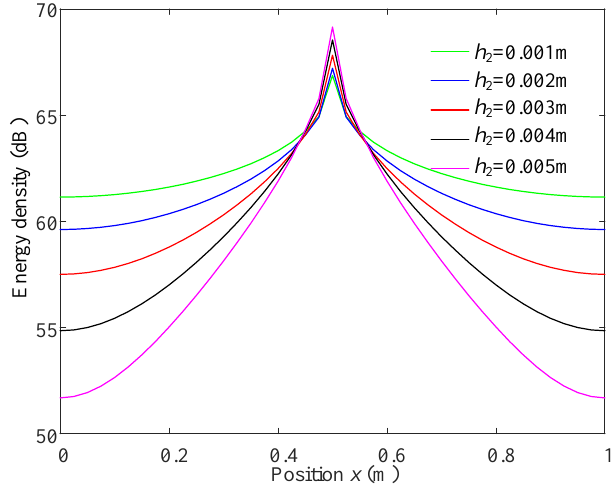
Figure 7. Energy density distribution for a plate with FFLD treatment of various loss factor of damp- ing layer ( f = 3 kHz, h 2 = 0.002 m).